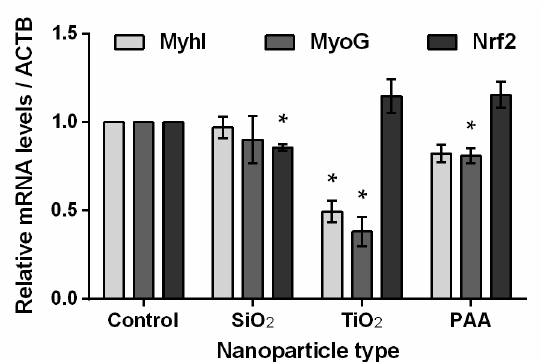
Figure 8. The influence of TiO 2 , PAA, and SiO 2 NPs on L6 cells differentiation and oxidative stress biomarkers. Fold change in gene expression of myosin I (MyhI), myogenin (MyoG), and nuclear factor (erythroid-derived 2)-like 2 (Nrf2), after treating differentiating rat L6 cells for 10 consecutive days with SiO 2 , TiO 2 , and PAA NPs (50 μ g/mL). Results are normalized to Actin beta (ACTB) and shown as a fold increase compared to the non-treated control. Means with standard error are shown for three independent experiments, each performed in three replicates. Statistical significance is displayed as follows: * p ≤ 0.05.